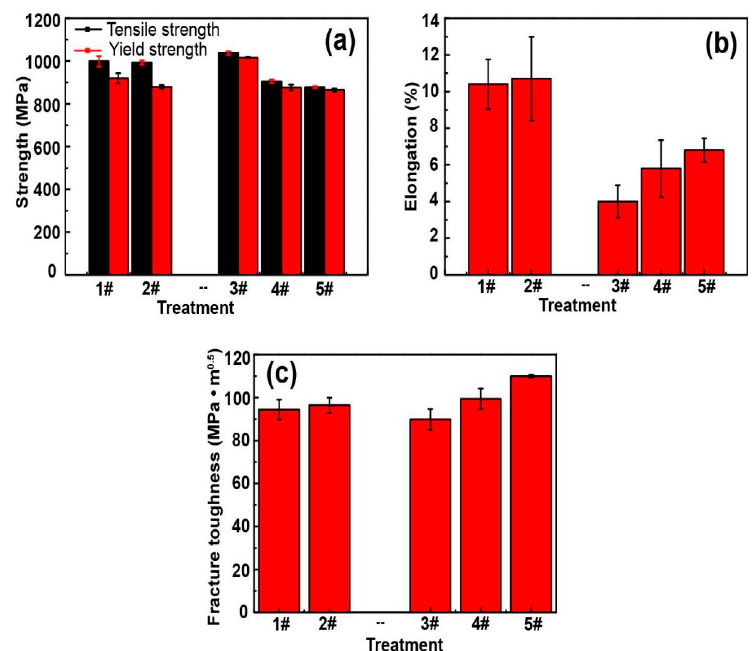
Figure 11. Mechanical properties of TC4F after heat treatments. ( a ) Strength, ( b ) elongation, and ( c ) fracture toughness. Table 4. Tensile properties of TC4F alloy after different heat treatments.